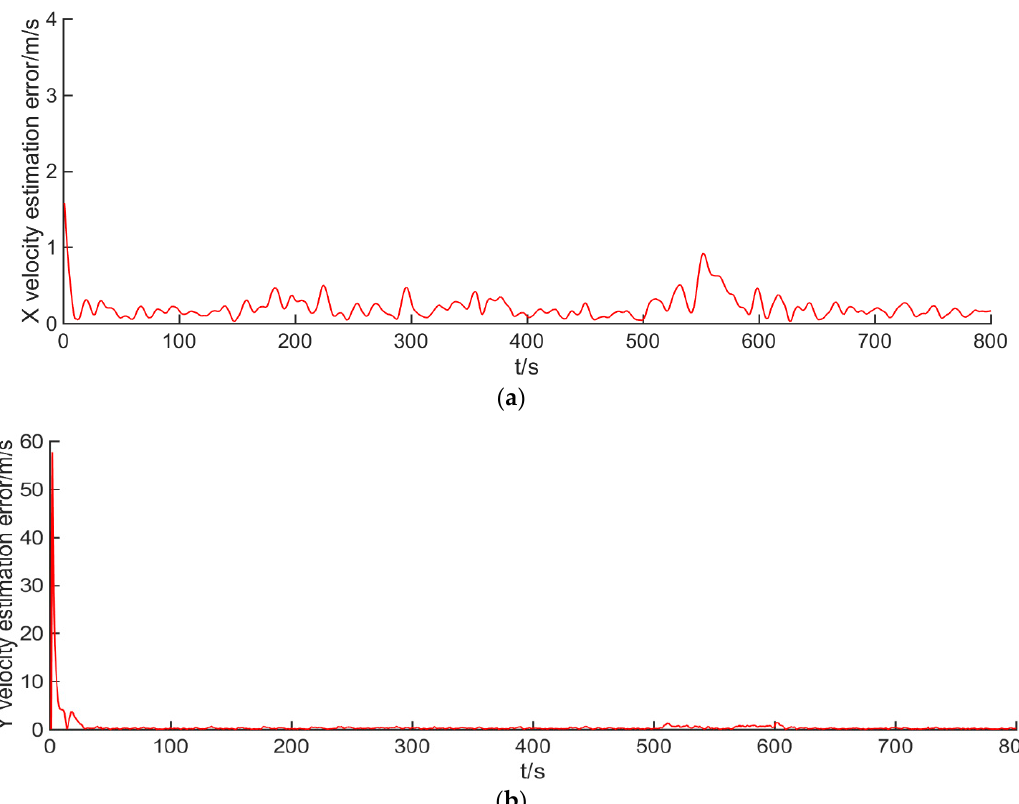
Figure 14. Velocity estimation results. ( a ) X velocity estimation error versus time; ( b ) Y velocity estimation error versus time.